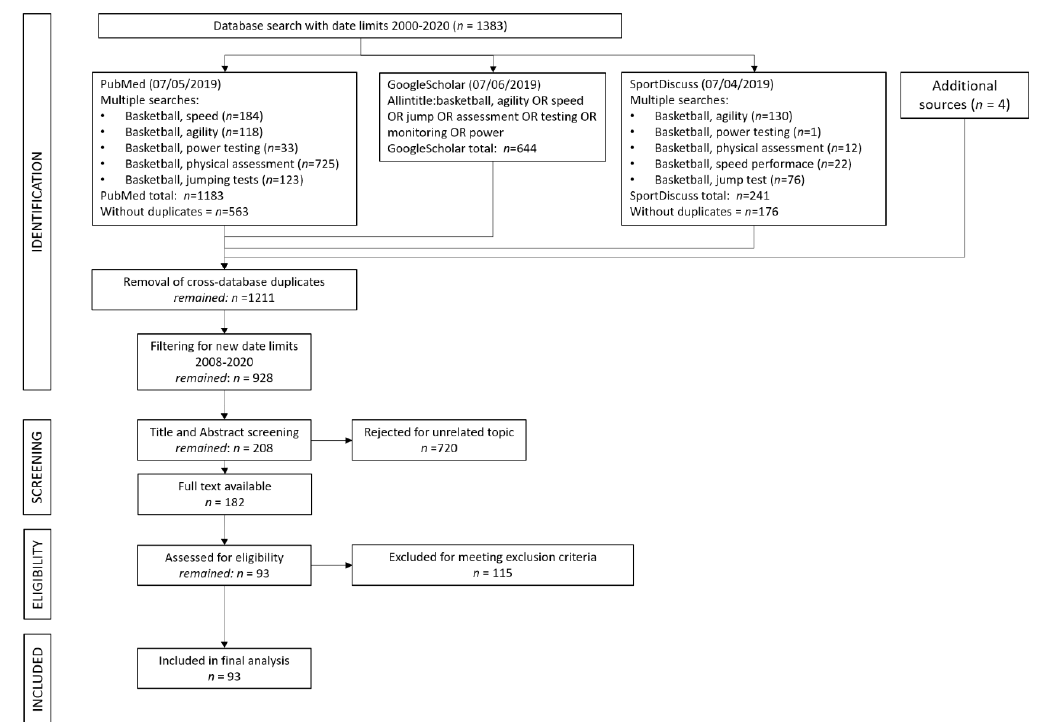
Figure 1. Flow diagram of search results and study identification.